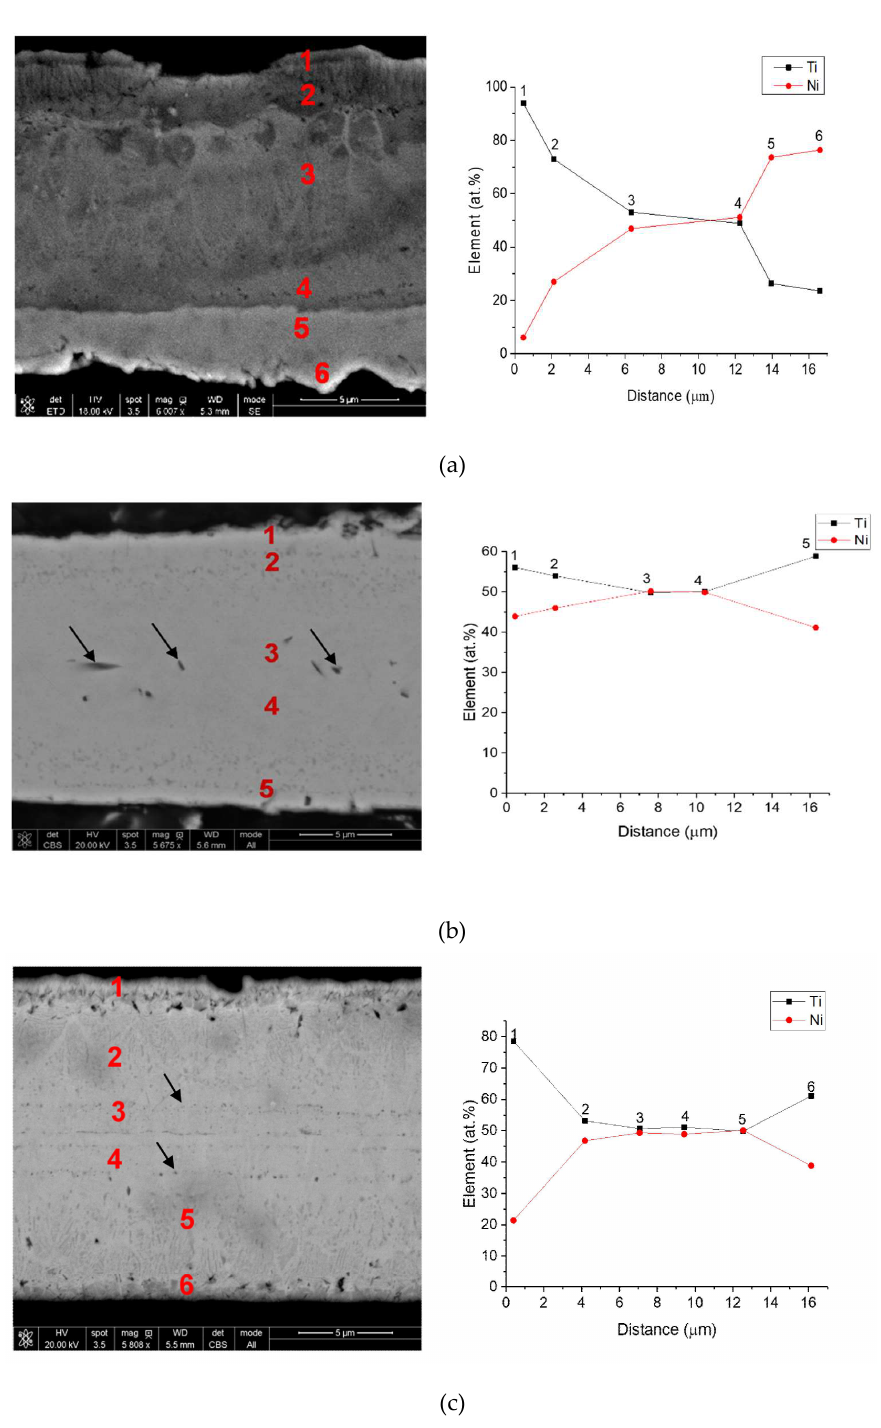
Figure 4. Back scattering electron-images (left) and energy dispersive X-ray spectroscopy results (right) for the cross-sections of: ( a ) ST2, ( b ) ST1, and ( c ) ST3 samples. Measured nickel/titanium contents correspond to the points on going from the top surface of the sample in the SEM image on the left side. The uncertainty is of order of the marked measurement point size. The arrows show the location of Kirkendall voids (Figure 4b,c).